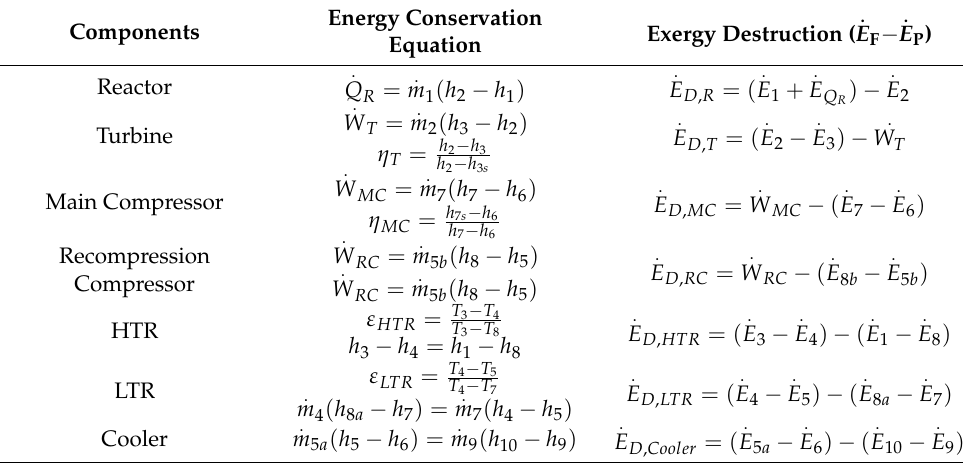
Table A1. Energy balance and exergy balance calculation equations of circulating